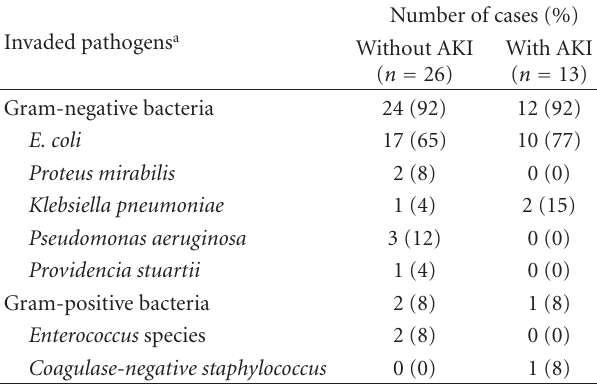
Table 2: Microbiological analysis of 39 patients with APN. Invaded pathogens